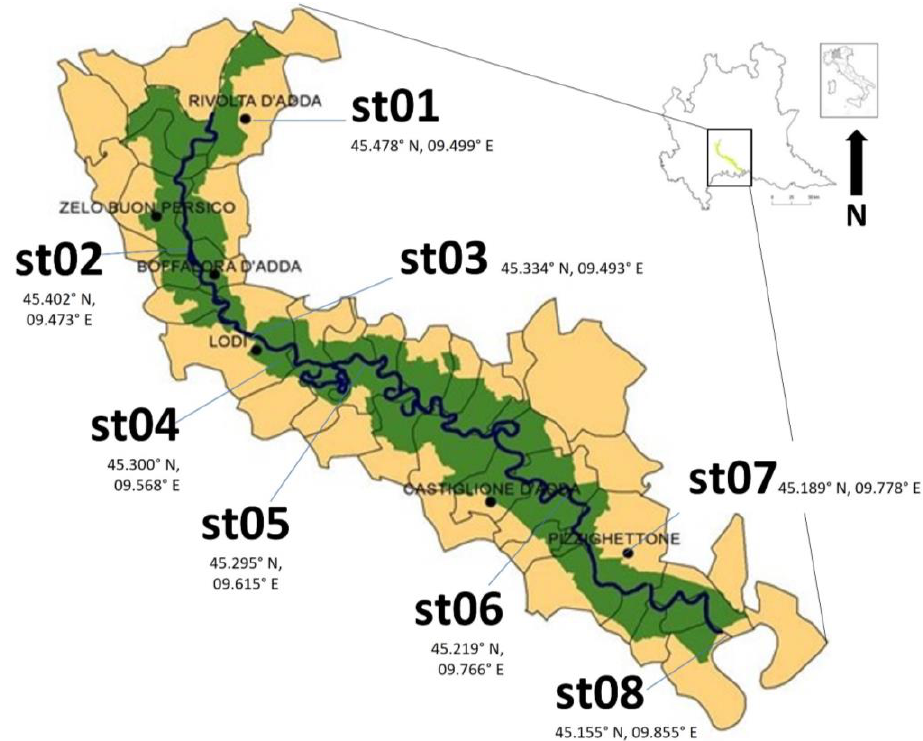
Figure 1. Study area: the main course of the River Adda in the administrative territory of the South Adda Regional Park. The coordinates are reported in WGS84.